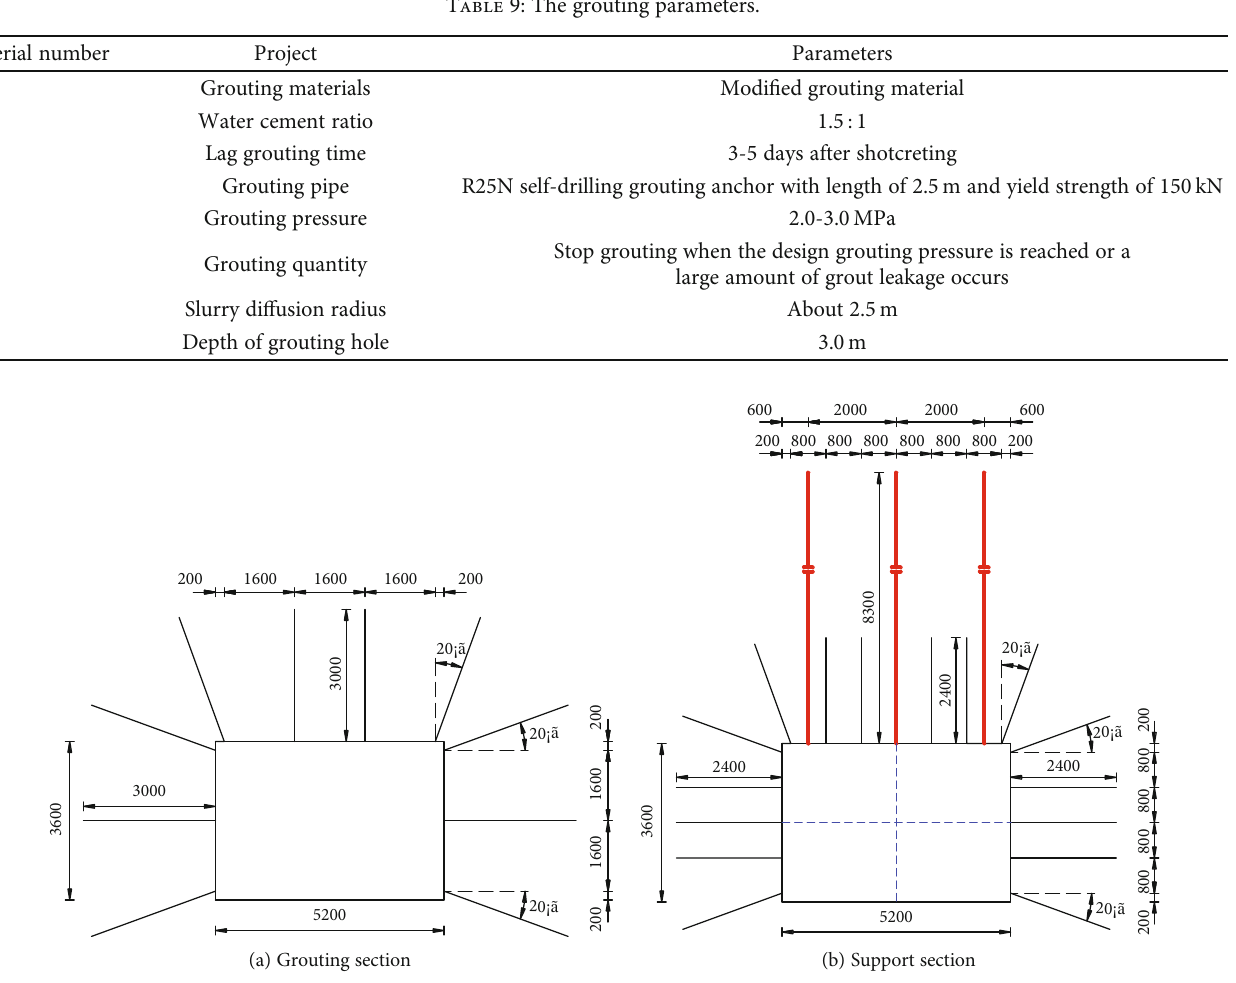
Figure 10: Roadway section with repair and reinforcement.